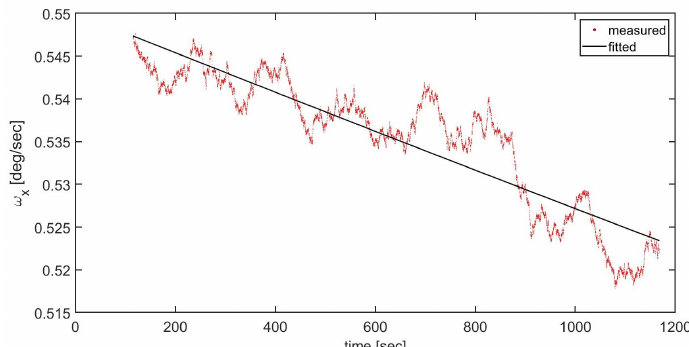
Figure 7. Measured (red) and interpolated (black) angular velocity during the PMACS characteriza- tion